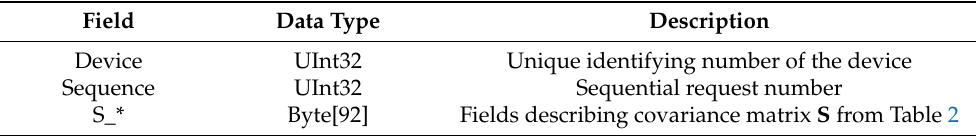
Table 3. Request for calibration message.